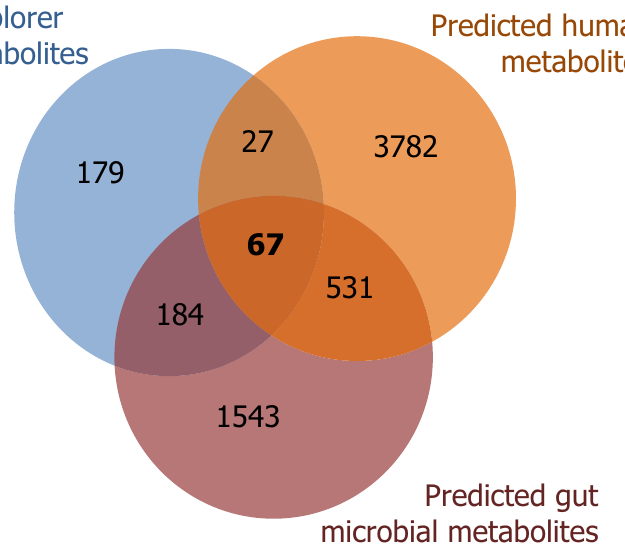
Figure 4. Venn diagram of gut microbial metabolites from the Exposome-Explorer database, the gut microbiota genome-scale metabolic models and the human genome-scale metabolic model.